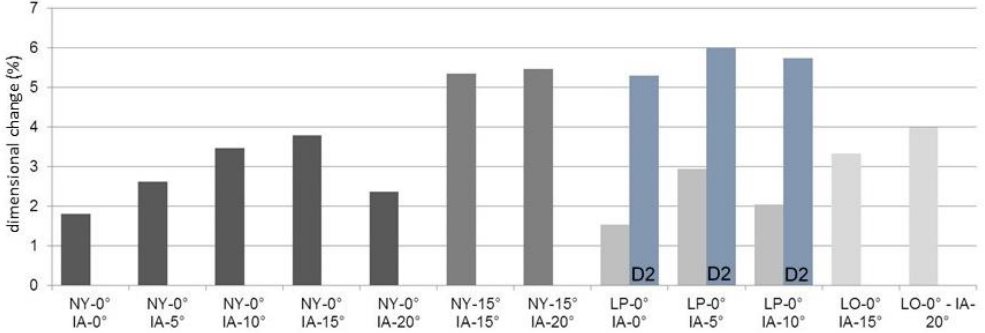
Figure 8. Percentage deviations of matrix geometry D1 (or D2) before and after simulated ageing; for labeling, refer to Table 1 and Figure 4.